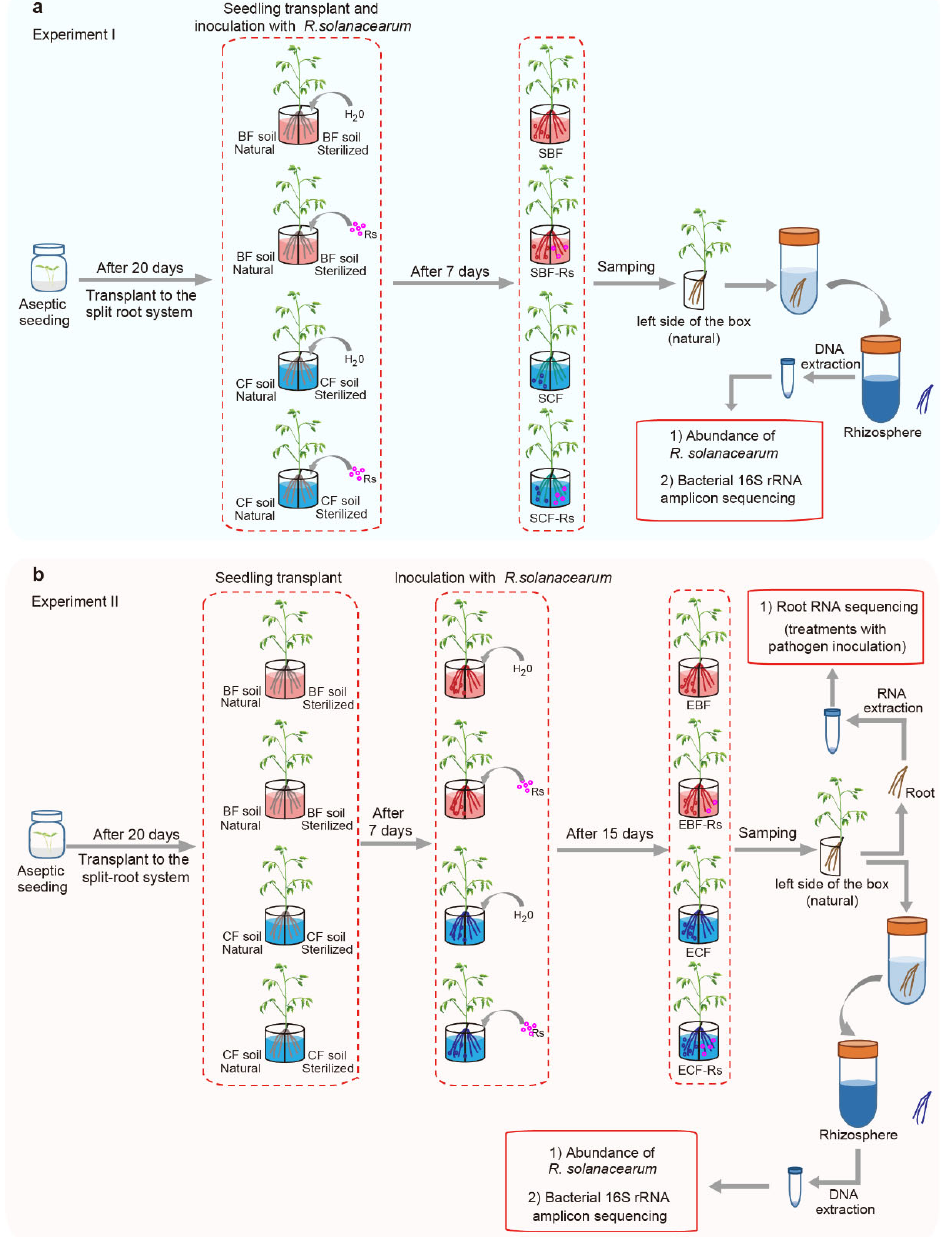
Figure 1. Schematic representation of the experimental systems used for the two independent experiments. Experiment I ( a ): the pathogen was inoculated at the same time that the seedlings were transferred to the split ‐ root system (S); SBF: rhizosphere derived from the BF soil without R. solanacearum inoculation; SCF: rhizosphere derived from the CF soil without R. solanacearum inoculation; SBF ‐ Rs: rhizosphere derived from the BF soil and inoculated with R. solanacearum at the same time that plants were transferred to the split ‐ root system; SCF ‐ Rs: rhizosphere derived from the CF soil and inoculated with R. solanacearum at the same time that plants were transferred to the split ‐ root system. Experiment II ( b ): the pathogen was inoculated 7 days after the seedlings were transferred to the split ‐ root system (E). EBF: rhizosphere derived from the BF soil without R. solanacearum inoculation; ECF: rhizosphere derived from the CF soil without R. solanacearum inoculation; EBF-Rs: rhizosphere and root derived from the BF soil and inoculated with R. solanacearum 7 days after the plant establishment in the split-root system; ECF-Rs: rhizosphere and root derived from the CF soil and inoculated with R. solanacearum 7 days after the plant establishment in the split-root